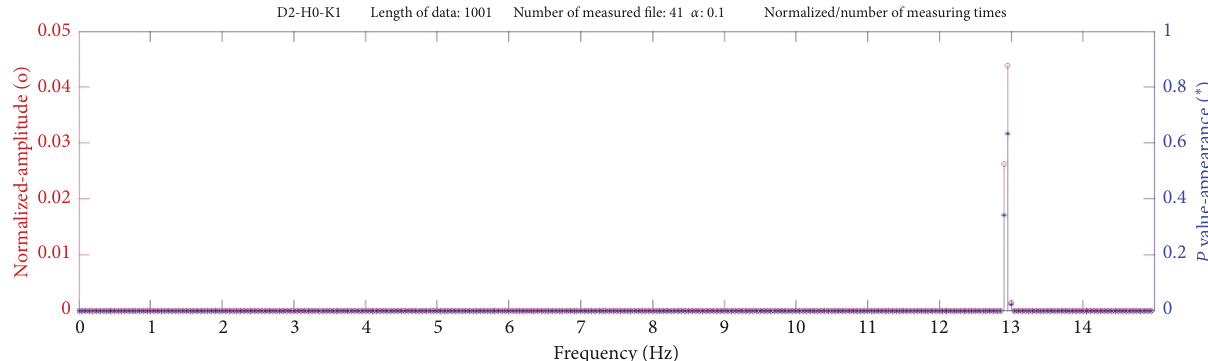
Figure 15: Power spectral density of freely vibrating beams.